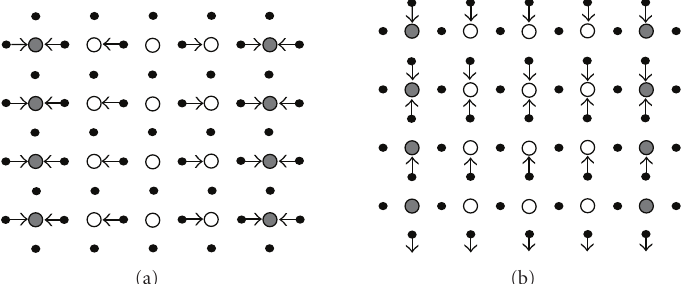
Figure 20: Schematic of the eigenvectors for the phonons with q = (0.25 0 0) propagating perpendicular (a) and parallel (b) to the stripes. Open circles represent hole-poor antiferromagnetic regions, while the filled circles represent the hole-rich lines (from [37]).